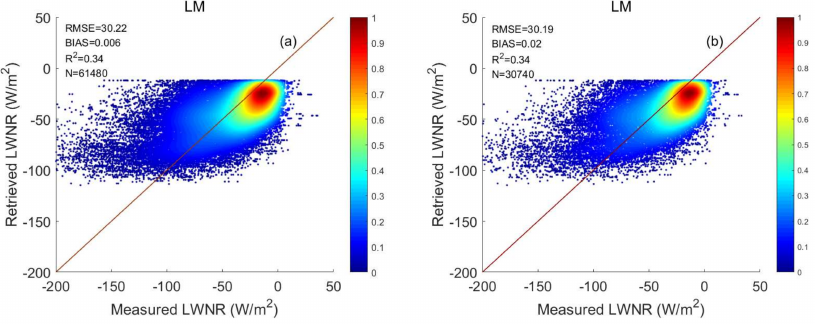
Figure 3. Accuracy of the linear model (LM): ( a ) training results and ( b ) validation results.